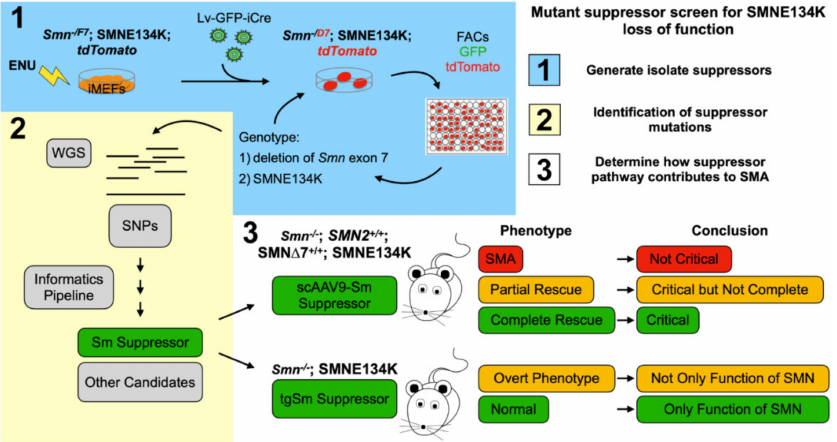
Figure 3. Mutant suppressor screen for SMNE134K loss of function. ( 1 ) Pictorial representation of the random mutagenesis screen and isolation of SMNE134K mutant suppressor lines. Smn − /F7 ;SMNE134K iMEFs were mutagenized with N -ethyl- N -nitrosourea (ENU) then treated with a lentivirus delivering iCre-recombinase and Green Fluorescent Protein (GFP) to delete Smn exon 7 from the Smn F7 allele (now Smn D7 ). iCre activity is monitored by the removal of a floxed-stop codon upstream of tdTomato, activating tdTomato expression. Cells were sorted by FACs to enrich the tdTomato and GFP double positive population of cells and were seeded at low density. Surviving colonies were picked, expanded, and genotyped for retention of SMNE134K and deletion of Smn exon 7 using ddPCR. Cell populations which showed greater than 70% deletion of Smn exon 7 were kept and pushed to 100% deletion by additional lentivrial transfection of iCre and dilution cloning. ( 2 ) Whole genome sequencing (WGS) was performed on surviving Smn − /D7 ;SMNE134K mutant suppressor lines to identify variant SNPs not common to the unmutagenized Smn − /F7 ;SMNE134K cell lines. Resultant variant SNPs were prioritized in a candidate list and culminated in testing whether a mutation in an Sm protein was responsible for suppression of Smn − /D7 ;SMNE134K lethality. This Sm Suppressor indicates Sm-assembly is the essential function of SMN in iMEFs. ( 3 ) Outline of experiments that should determine whether rescue of Sm-assembly is critical to SMA. In ∆ 7 SMNE134K SMA mice, an AAV9 delivering the Sm suppressor can result in three outcomes: no modification of the SMA phenotype, a partial rescue, or complete rescue. Additionally, transgenic expression of the Sm suppressor in an Smn null, SMNE134K-expressing mouse can have two outcomes: development of an overt phenotype or normalcy. Each of these outcomes suggests a different conclusion, thus showing how suppressor screens can inform on the critical function of SMN regarding